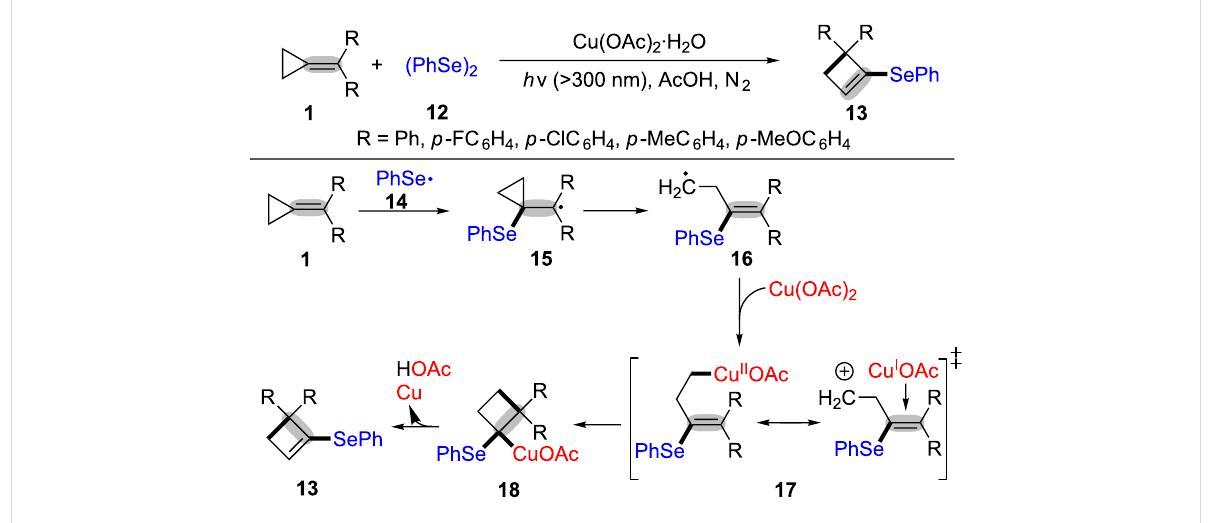
Scheme 5: Copper(II) acetate-mediated oxidative radical ring-opening and cyclization of MCPs with diphenyl diselenides.